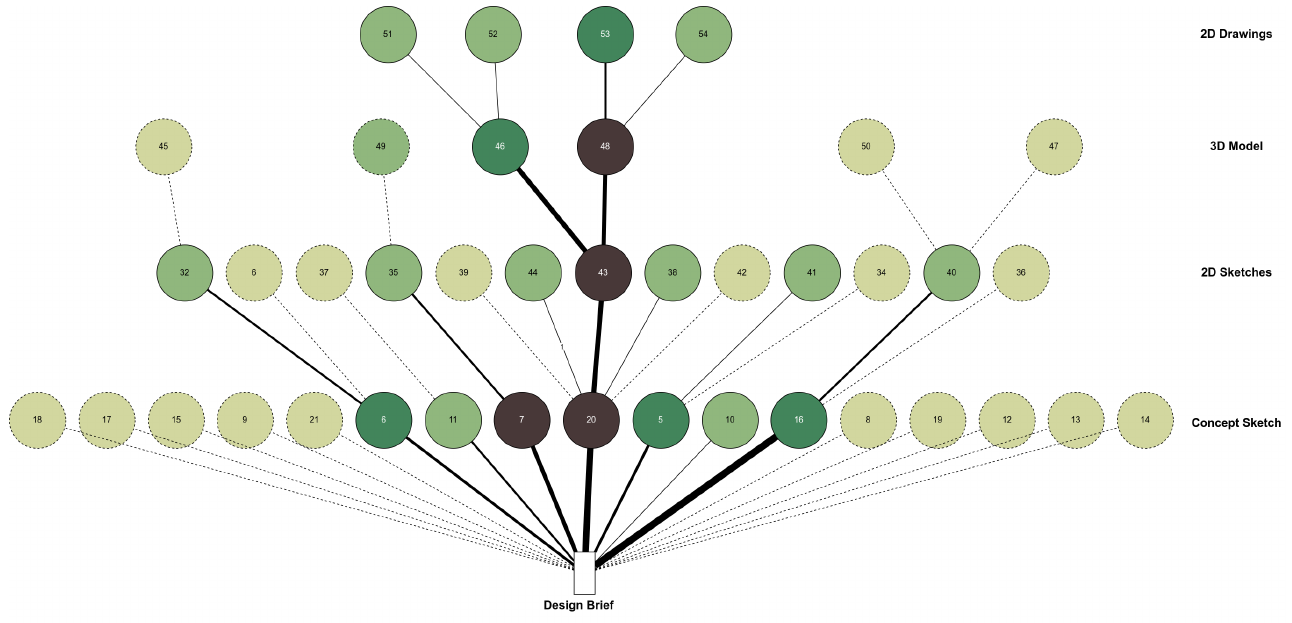
Figure 5. Design development tree diagram. Each level represents a DSR block. The selected designs appear in a deeper tone, while the designs that were not selected by the community are presented in a lighter